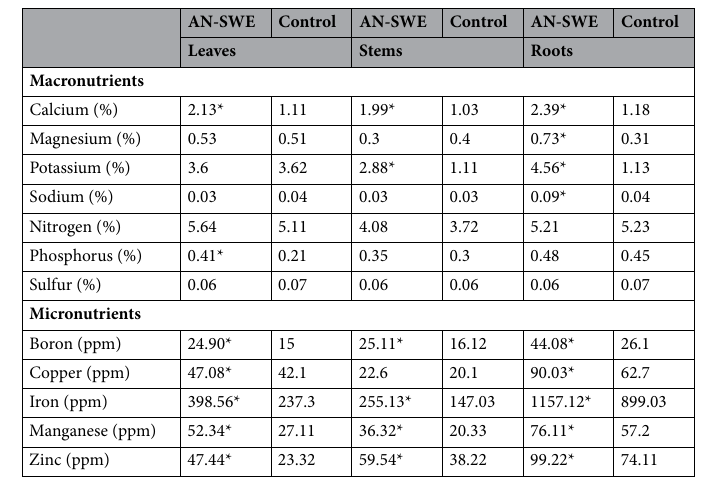
Table 2. Effects of AN-SWE on the nutrient contents of leaves, stems and roots of tomato plants. The data represents the average measurements from three randomly selected plants (SD values were < 0.02). The data was analysed for significant differences by Student’s t-test and significance represented by an